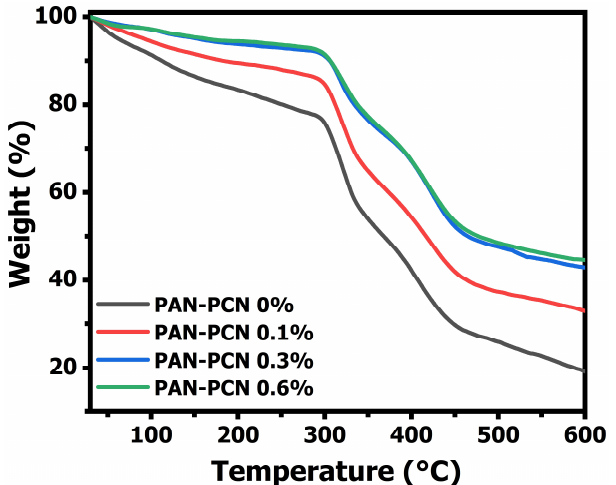
Figure 5. Thermogravimetric analysis (TGA) curves of PAN-PCN 0%, PAN-PCN 0.1%, PAN-PCN 0.3% and PAN-PCN 0.3% and PAN-PCN 0.6%.